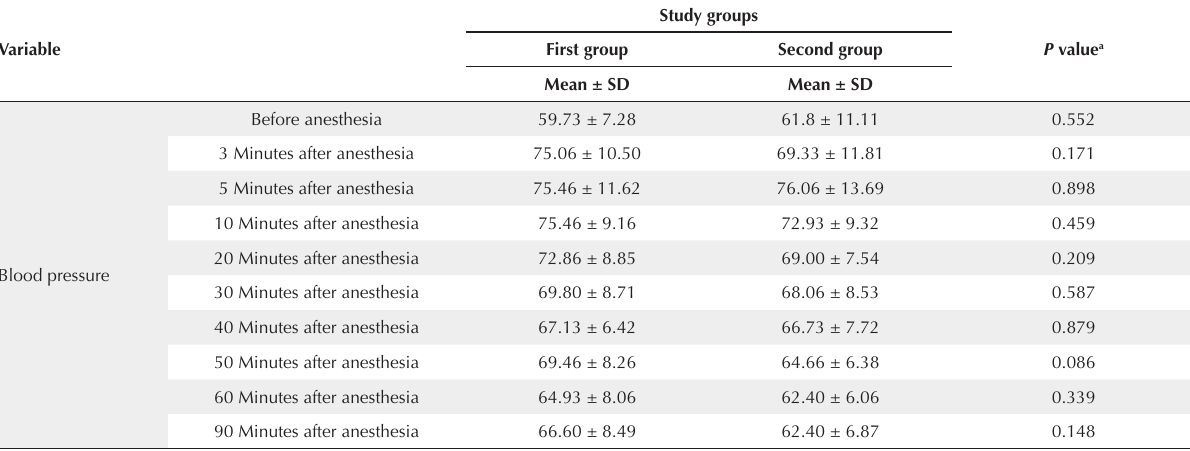
Table 2. The mean and SD of blood pressure in the patients of the first (ropivacaine) and second (lidocaine with epinephrine) groups